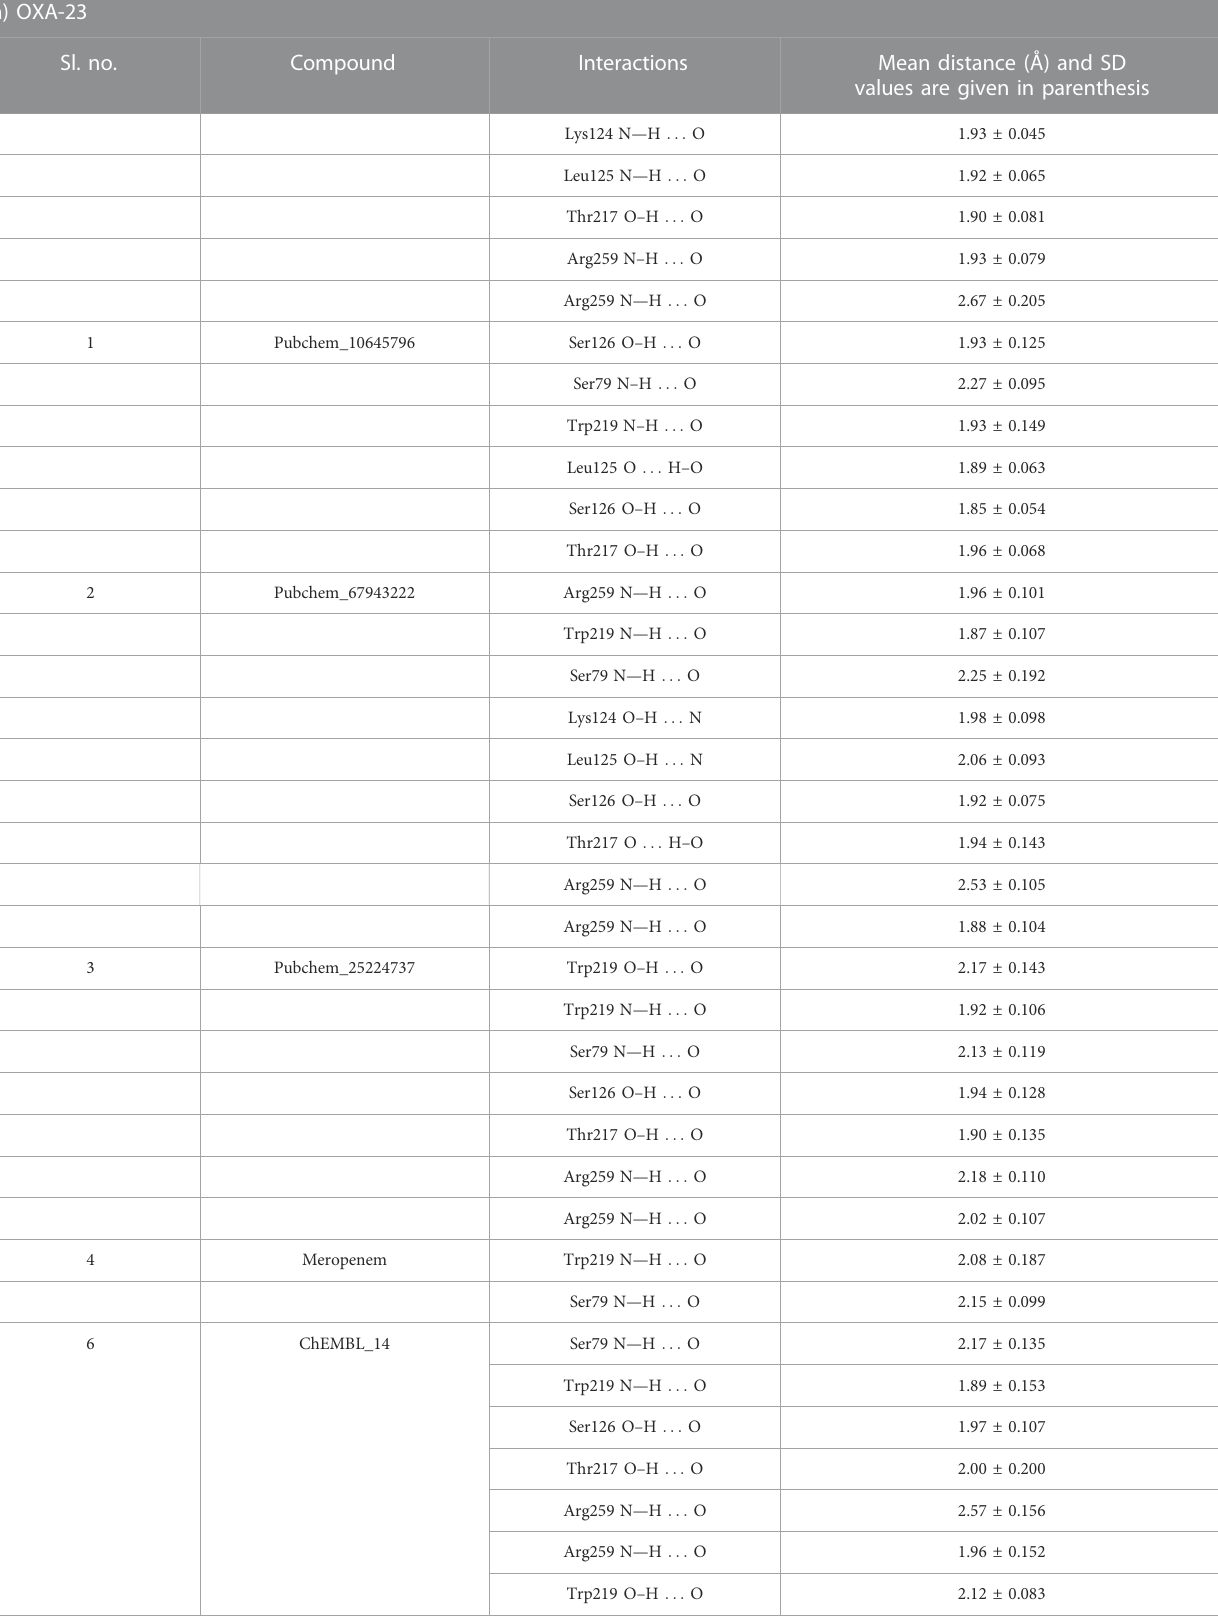
TABLE 4 Top compounds from the outcome of covalent docking against OXA-23 and OXA-27. a) OXA-23 Sl.